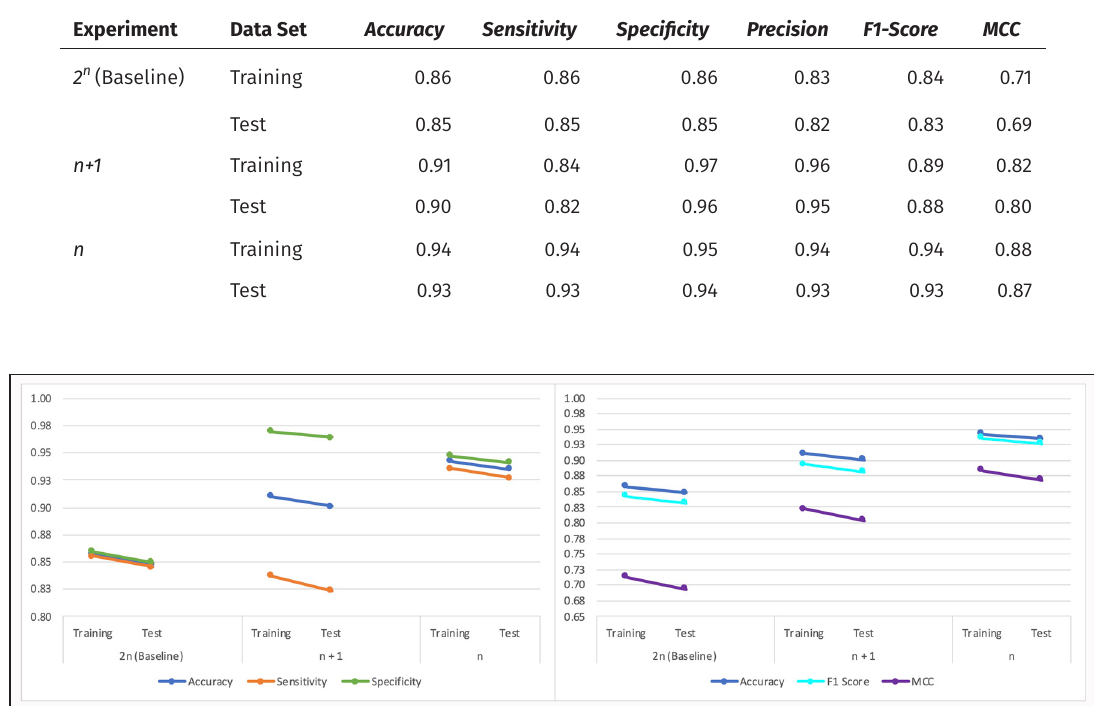
Table 9: Evaluation metrics for the classifier's overall discriminatory skills.